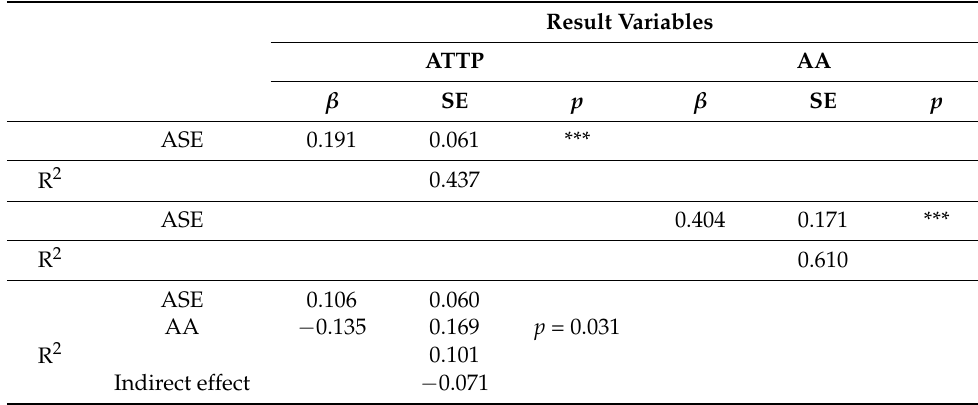
Table 8. Findings on direct and indirect relationships between variables. Result Variables ATTP